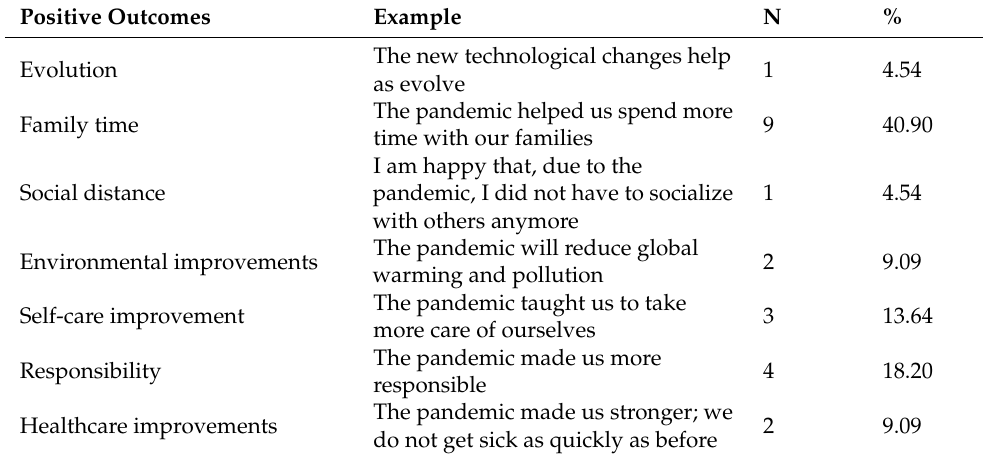
Table 7. Perception of the potential positive COVID-19 pandemic